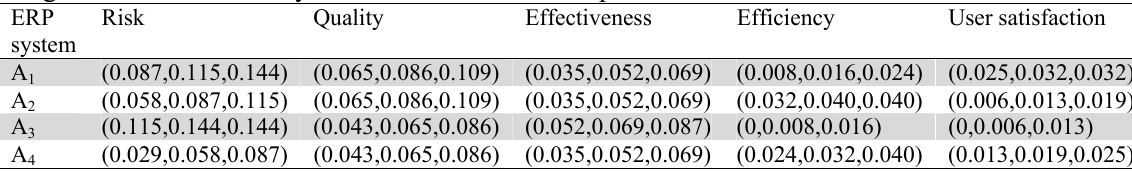
Weighted normalized fuzzy decision matrix for example 1